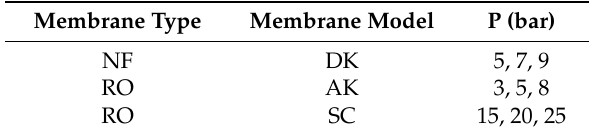
Table 2. Operating pressure values set on each